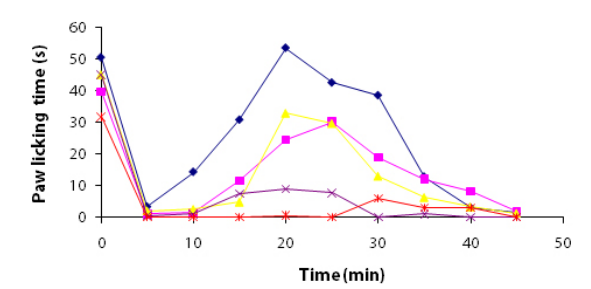
Figure 3. Analgesic activity of heated cobra venom on mouse inflammatory pain assay. Mice were first injected intraperitoneally with saline (dark blue squares); 20 µg/g dose of lidocaine (pink squares); 10 µg/g (yellow triangles) or 15 µg/g (violet “x”) of venom heated for 60 minutes; and 25 µg/g of venom heated for 300 minutes (red asterisk). After 15 min followed the formalin injection into a paw of mice and the paw-licking time was